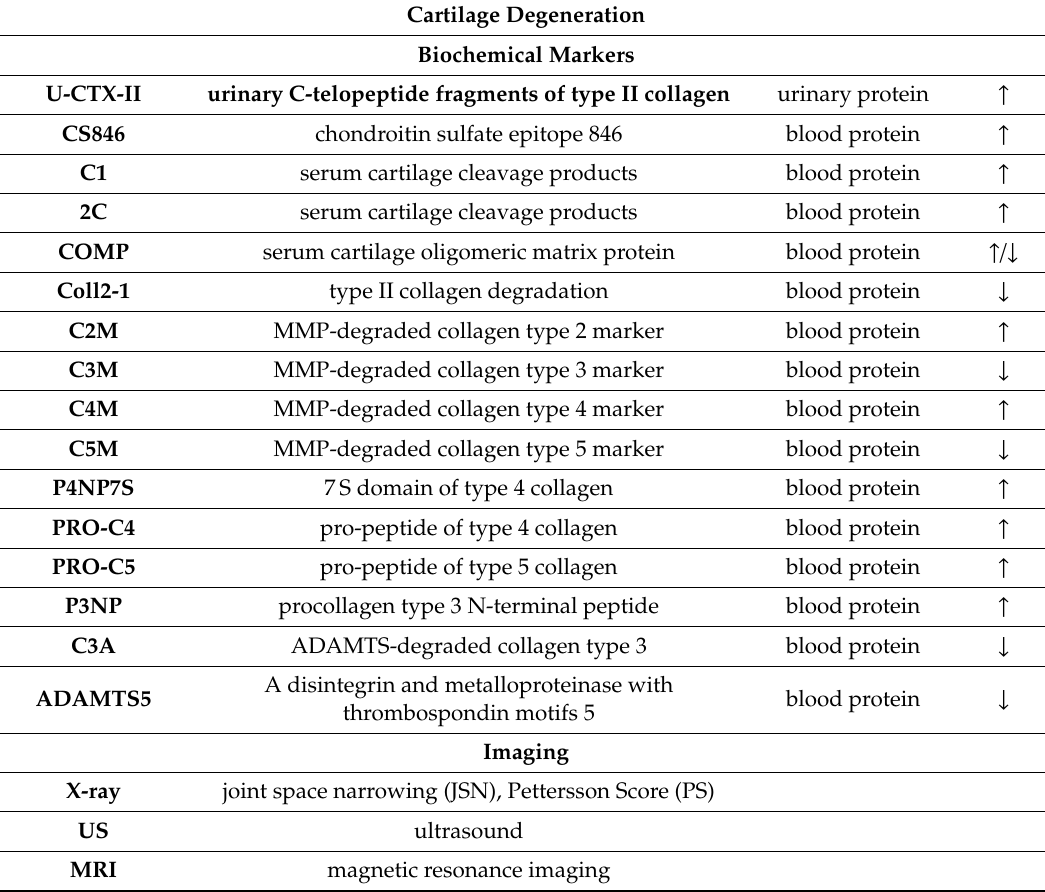
Table 4. Markers related to cartilage degeneration stage and their